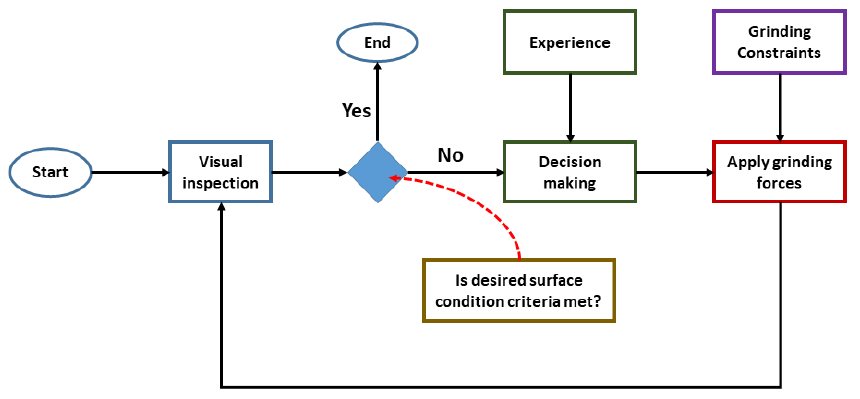
Figure 2. The manual stages involved in the manual grinding of fan blades during MRO.